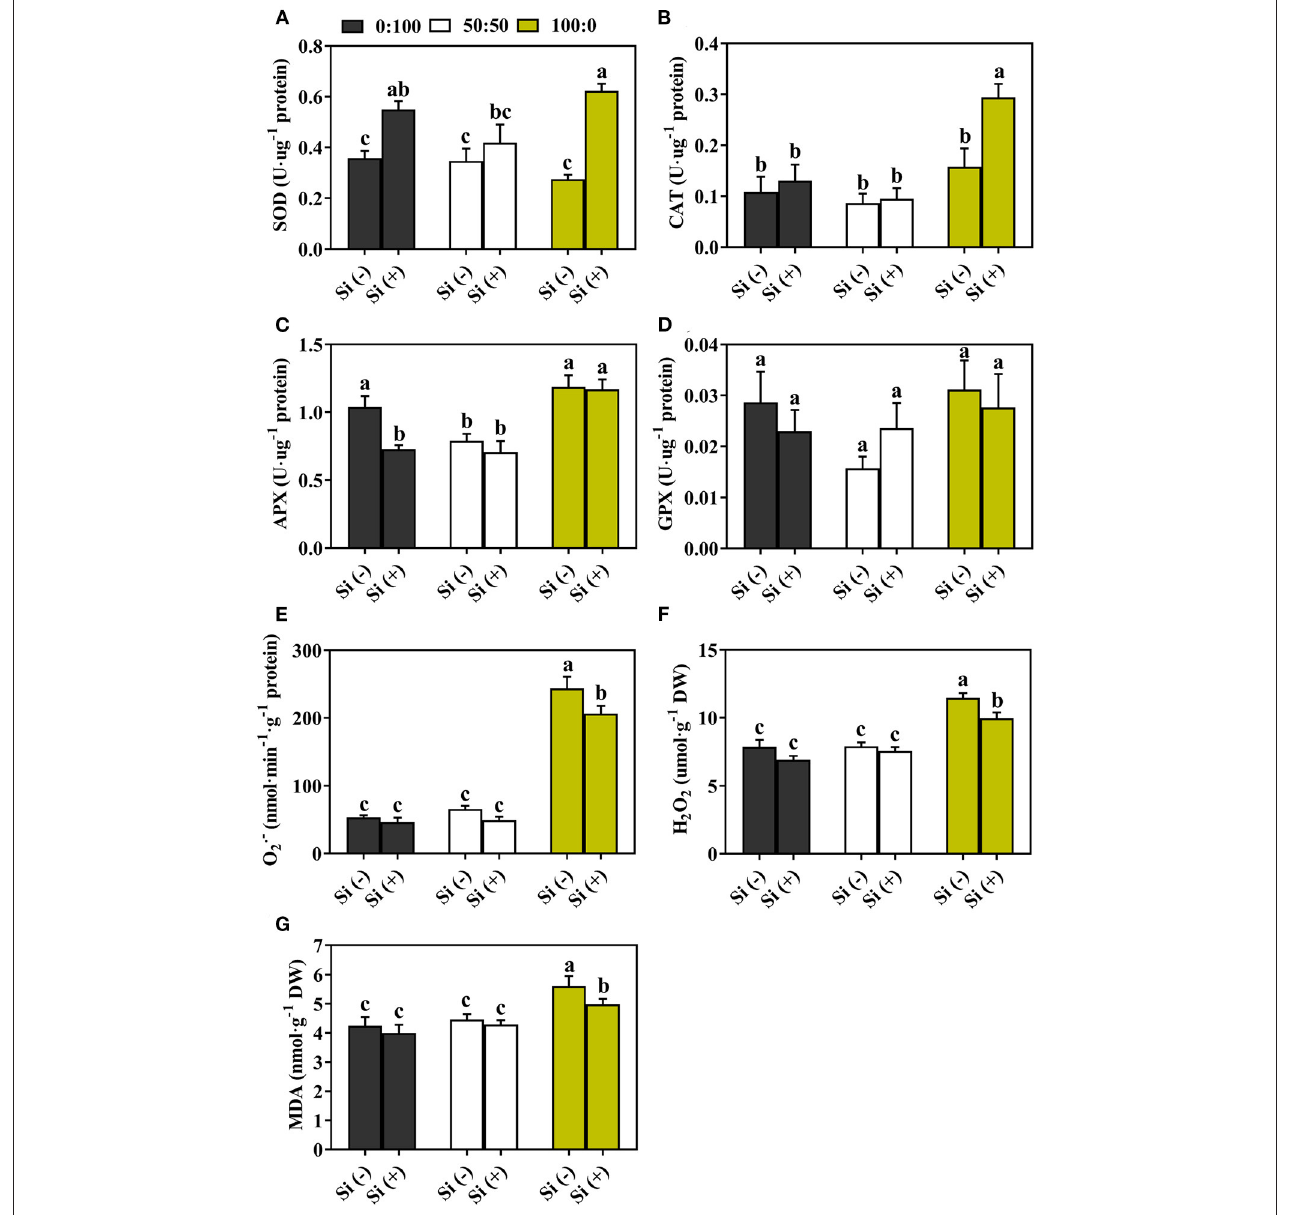
FIGURE 6 | Antioxidative enzyme activities of (A) SOD, (B) CAT, (C) APX, (D) GPX and contents of (E) O . − 2 (superoxide), (F) H 2 O 2 (hydrogen peroxide), and (G) MDA (malondialdehyde) in response to three NH + 4 :NO − 3 ratios with or without Si supplementations. Data are the average of at least n = 4 independent replicates ± standard deviation (SD); different letters over bars indicate the significant difference, which was determined by Duncan’s multiple range test at p =